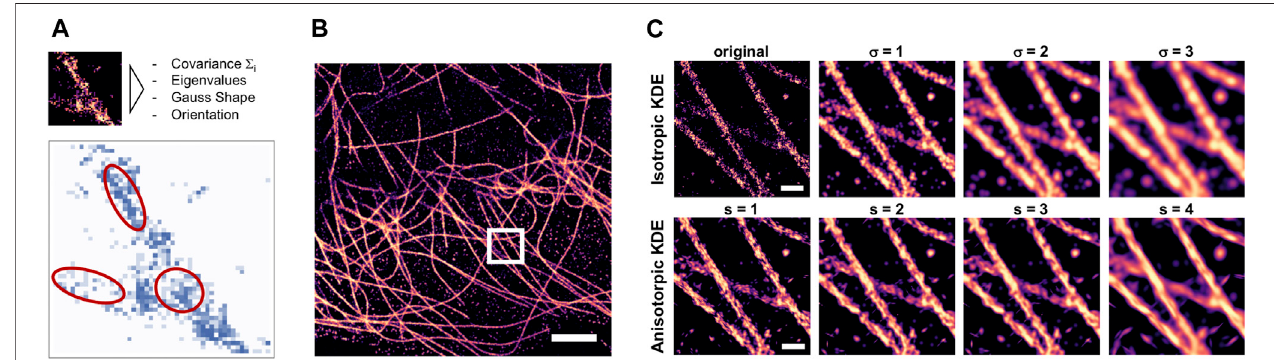
FIGURE 1 | Anisotropic KDE as density estimate for fi laments. (A) Illustration of the method as proposed by (Chen et al., 2014) but here implemented in image space; red ellipses indicate the different shapes and orientations of the 2D anisotropic Gaussian fi lter kernels. (B) Histogram rendering of a complete fi eld of view of a reconstructed dSTORM image of microtubules in a COS7 cell, scale bar (cid:2) 2 μ m. (C) zoomed-in detail indicated by the box in b) (scale bar (cid:2) 0.2 µm), top: un fi ltered histogram (left) and density estimation by classical Gaussian fi ltering with fi xed sigma of 1 – 3 pixels, corresponding to 5 – 15 nm; bottom: same region, but with anisotropic KDE applied using an adaptive multivariate Gaussian kernel scaled by a factor of 1 – 4 (from left to